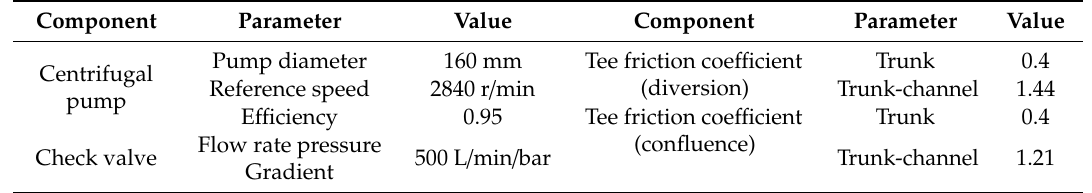
Table 2. Sub-models and parameters of main